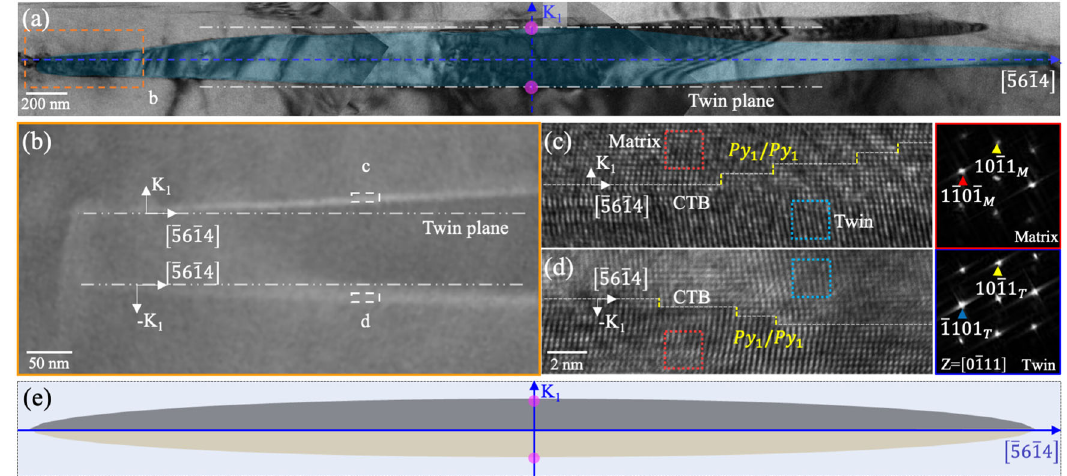
(cid:4) (cid:5) (cid:6) (cid:7) Fig. 5 TEM micrographs of a 1011 twin in 0111 view. a A lenticular-shaped twin domain in low magni fi cation image. b The HAADF image showing the twin tip enclosed by the or a nge rectangle in a . c , d High magni fi cation images of the regions enclosed by the white rectangles in b showing Py 1 /Py 1 facets on ± K 1 boundaries. The insets are the FFT of the regions enclosed by the red and blue squares, (cid:4) (cid:5) (cid:6) (cid:7) con fi rming the matrix and twin orientation. e Schematic showing the geometric shape of 1011 twin in 0111